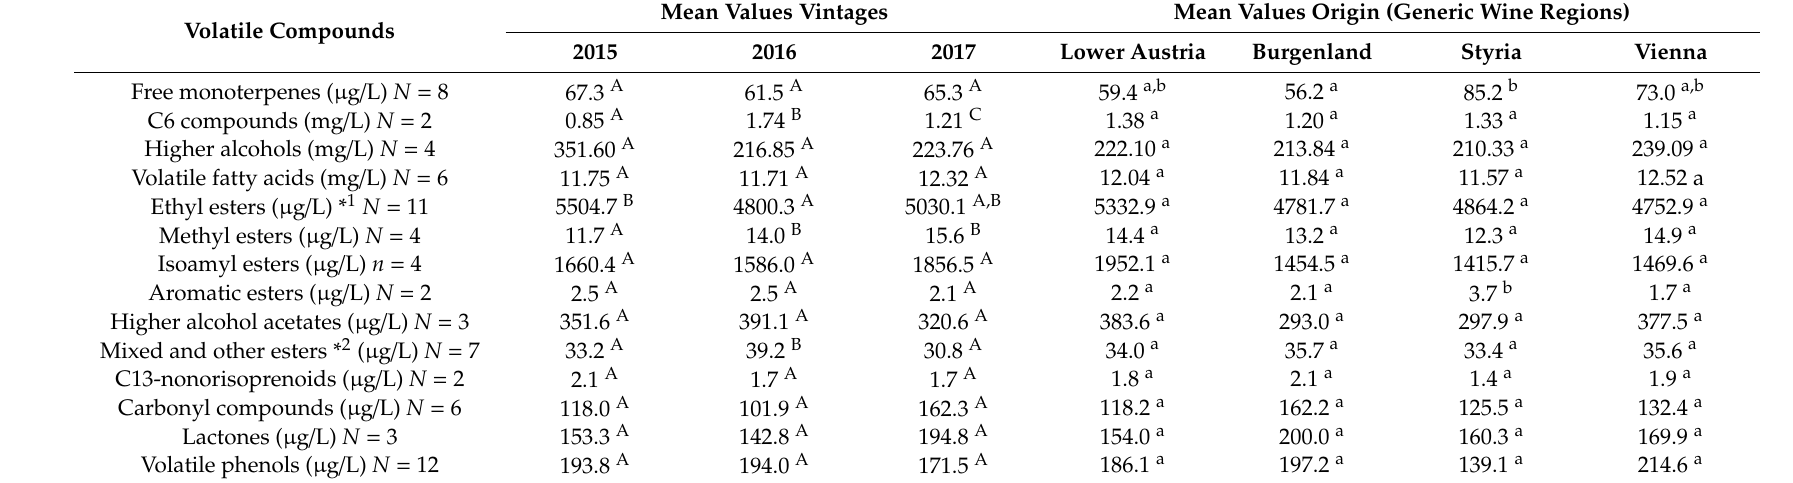
Table 1. Concentrations of the volatile substance